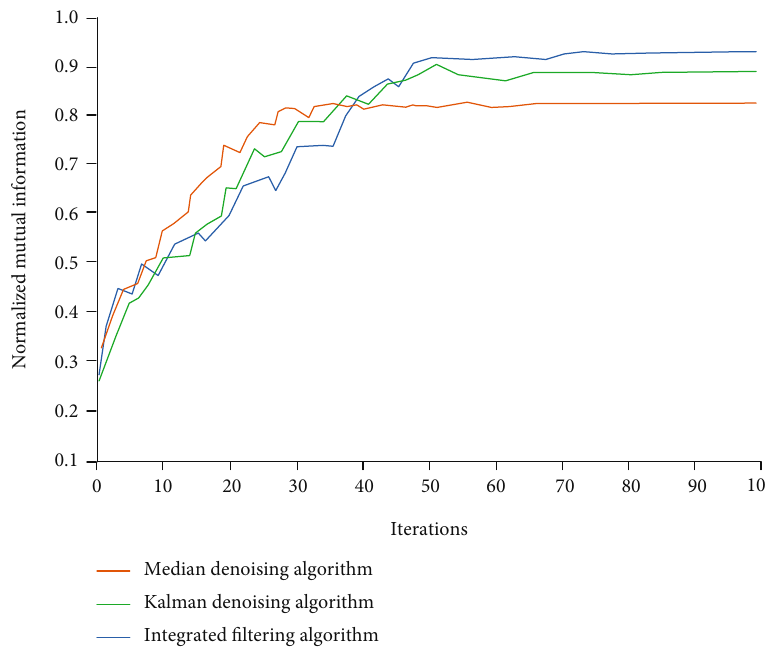
Figure 7: Statistical results of mutual information quantity of each fi ltering algorithm.